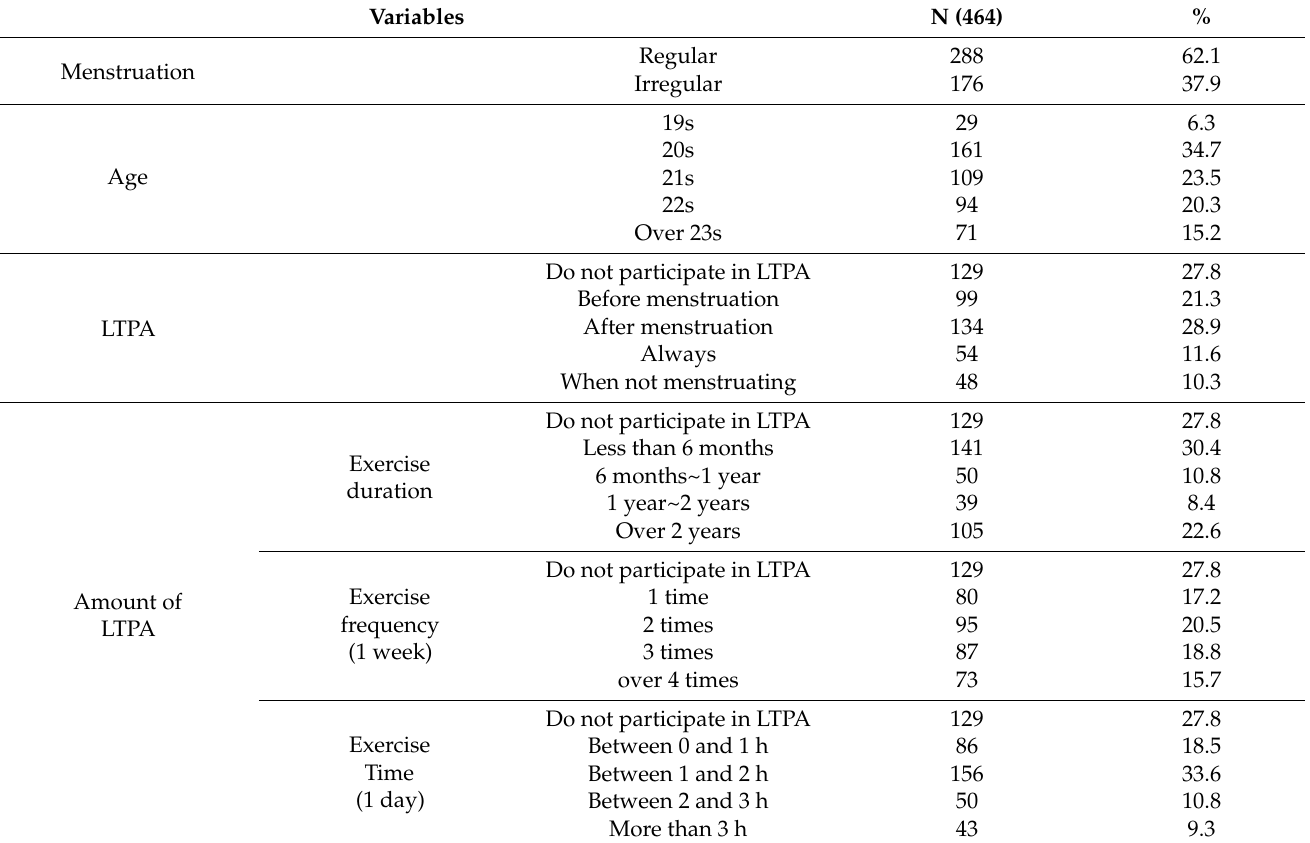
Table 1. The individual characteristics of the study subjects (N =